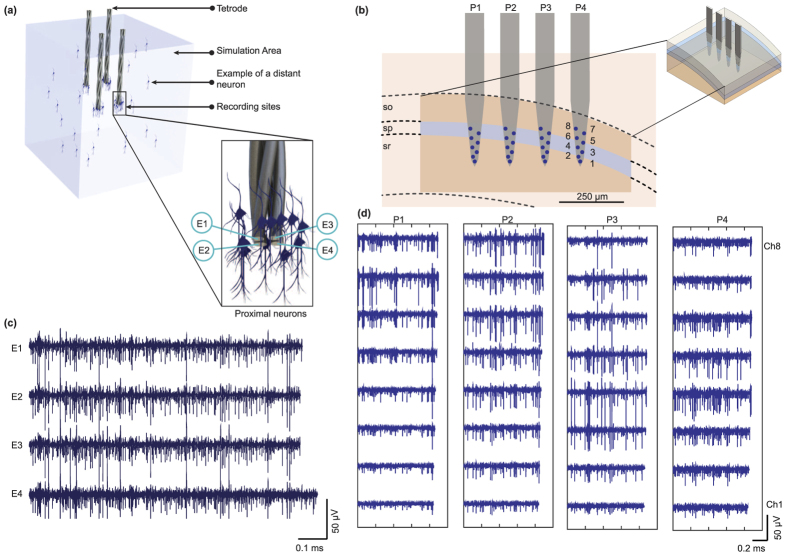
A data-driven model of the neural signal simulator.(a) The extracellular action potential simulator was modified from25 to integrate several virtual recording sites (i.e. 4 tetrodes) with different configurations of hippocampal neural populations. The model computes the extracellular action potential waveforms using detailed compartment models of pyramidal cells for nearby neurons and uses action potential templates from real recordings to simulate distant neurons. The result is the contribution of close and distant neurons using the line source approximation (LSA) method58 in a 3D virtual volume of tissue. (b) Modelling of a portion of virtual rat hippocampus with a 32-channel polytrode array (8 sites x 4 shanks, dimensions follow Buszaki64 probe from NeuroNexus) superimposed across (following a stereotaxic view) the stratum radiatum (sr), stratum pyramidale (sp) and stratum oriens (so) in the CA1 region of rat hippocampus. Data for dimensions and contours of rat hippocampal regions were measured from Swanson’s rat brain atlas to determine the dimensions of our volume, particularly between the atlas levels 30- = 35. A parasagittal view in the Figure shows atlas level 3159 (AP = −3.70 mm relative to Bregma, ML 2–3 mm, DV 2–3 mm). (c) Signal samples from one extracellular virtual tetrode. (d) Polytrode simulation datasets over one second are shown for each virtual polytrode. The activity across channels reflects the signal location of the virtual recording sites.